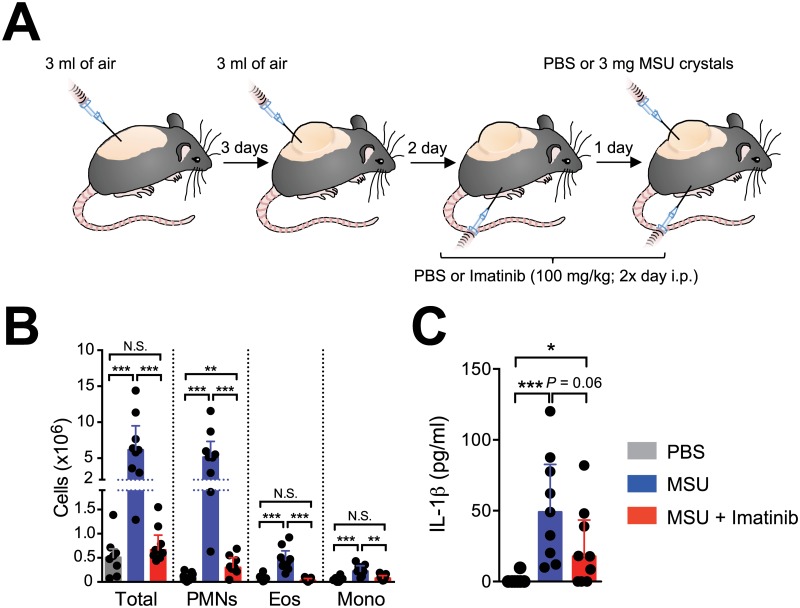
Prophylactic treatment with imatinib reduces MSU crystal-induced inflammation in the air pouch model.(A) Experimental outline. Mice were anesthetized, shaved on the back, and injected with 3 ml of sterile air subcutaneously (s.c.) into the back to form an air pouch. Three days after the first injection, an additional 3 ml of sterile air were injected into the pouch. Three days later, we injected 3 mg of MSU crystals in 1 ml PBS, or PBS alone, into the air pouches. Mice received intra-peritoneal (i.p.) injections of imatinib (100 mg/kg i.p. in 200 μl PBS) or vehicle (PBS) twice a day starting 24 h before the injection of MSU crystals. (B) Number of total cells, neutrophils (Ly6G+; CD11b+), eosinophils (SSChigh; Siglec-F+) and monocytes (Ly6G-; CD11b+) in air pouch exudates collected 6 h after injection of MSU crystals or PBS. (C) Levels of IL-1β in air pouch exudates collected 6 h after injection of MSU crystals or PBS. Data in B and C are depicted as values from individual mice, with histograms indicating medians + quartiles of data pooled from the three independent experiments performed with a total of n = 8 (‘PBS’ group) or n = 9 (‘MSU’ and ‘MSU + Imatinib’ groups) mice. *, ** or *** = P < 0.05, 0.01 or 0.001 vs. indicated group by Mann-Whitney U test.